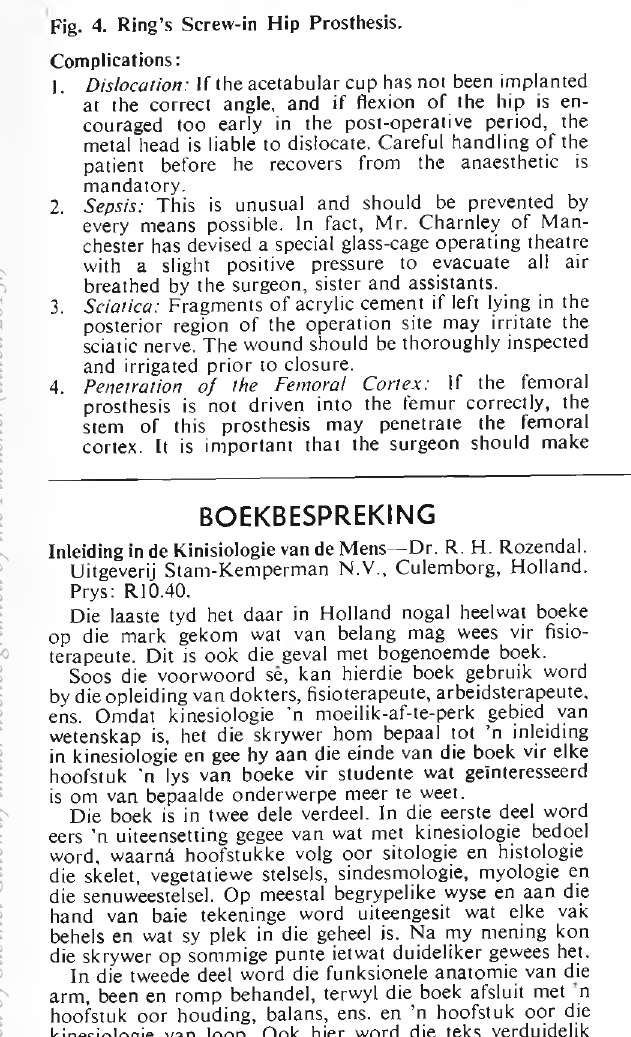
Fig. 4. Ring’s Screw-in Hip